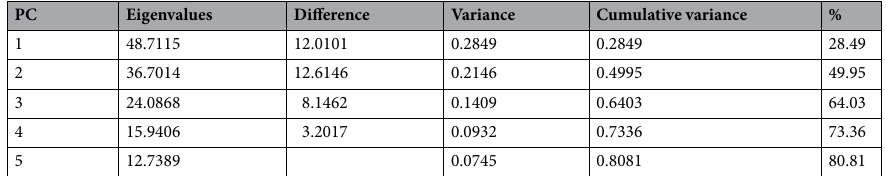
Table 4. Characteristic values and their accumulated proportion for five first principal components from the analysis of 229 morphological, biochemical, genetic, and biological activity variables of ten Sechium spp.